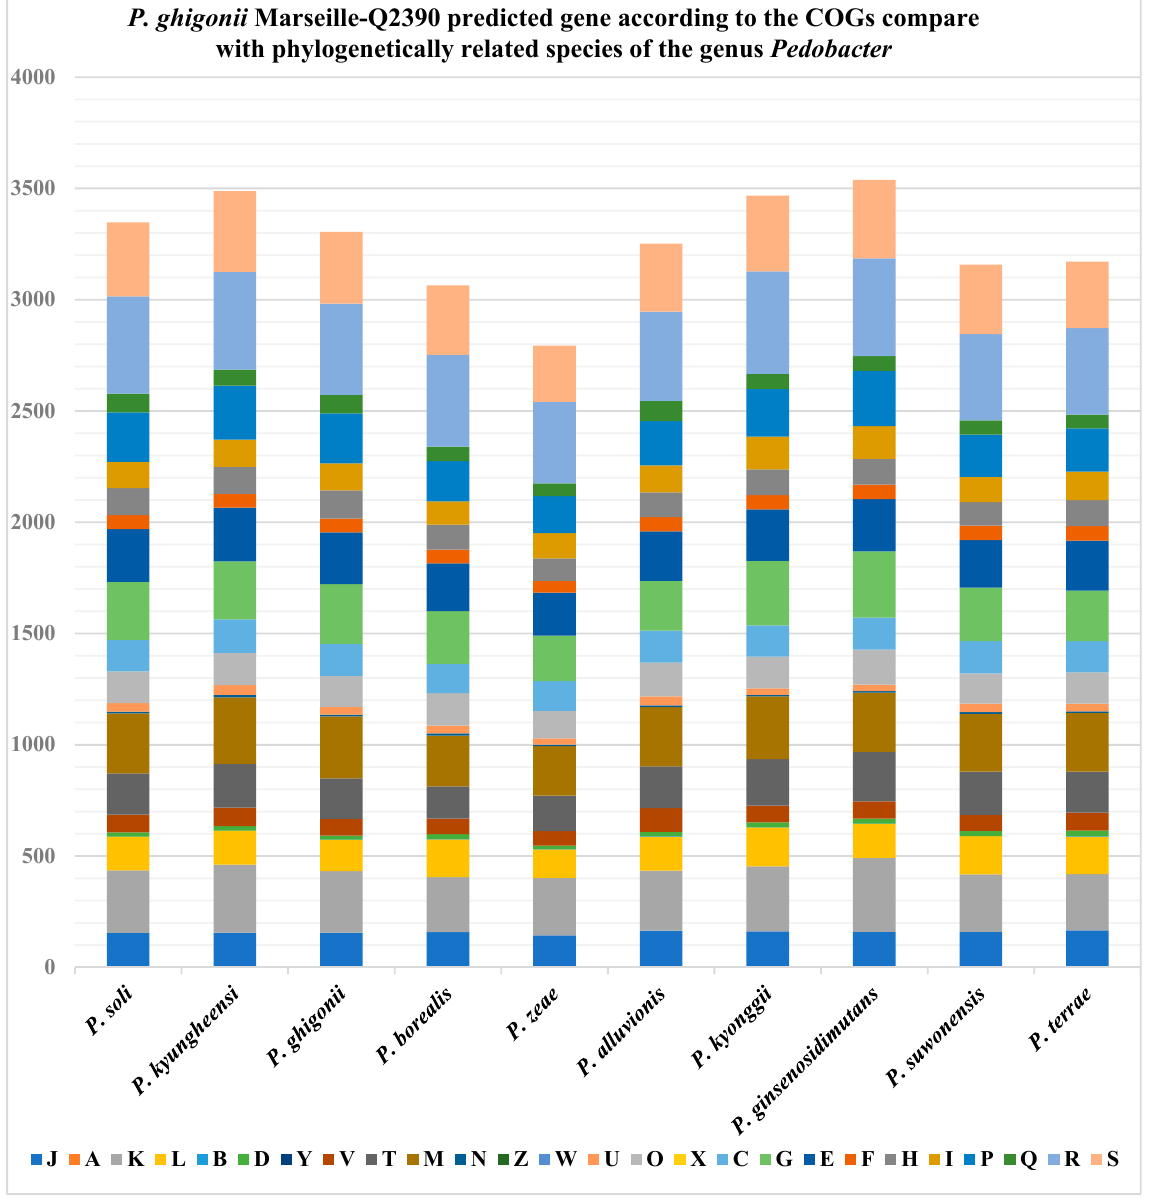
Figure 3. Comparison of gene functional categories of the strain Marseille-Q2390 and other Pedobacter species.